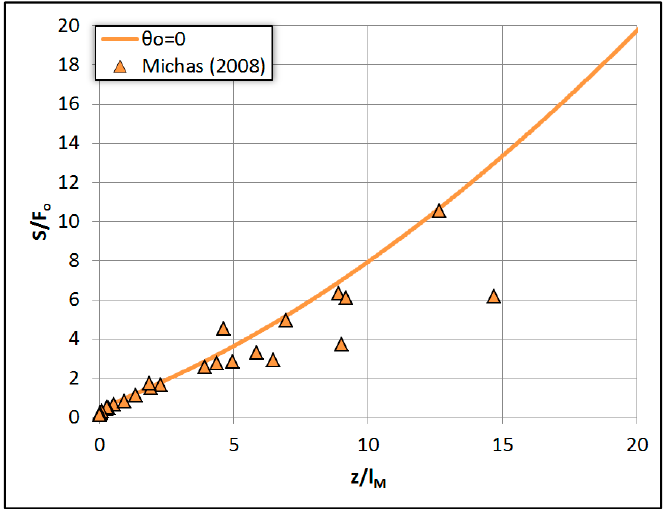
Figure 4. Comparison between model and experimental results [11] regarding the axial dilution S/F o of positively buoyant heated jets.